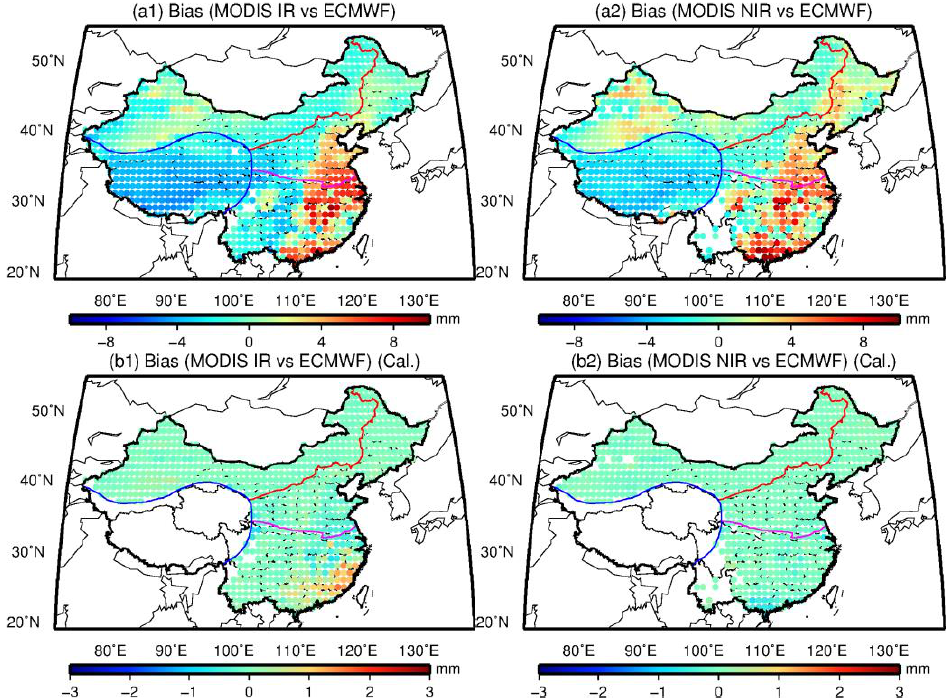
Figure 11. Bias distribution of paired stations between MODIS and ERA-Interim over the period 2011 – 2017, where the first row ( a1 , a2 ) is the bias of MODIS IR/NIR PWV without calibration, and the second row ( b1 , b2 ) is the values with calibration using ERA-Interim PWV.